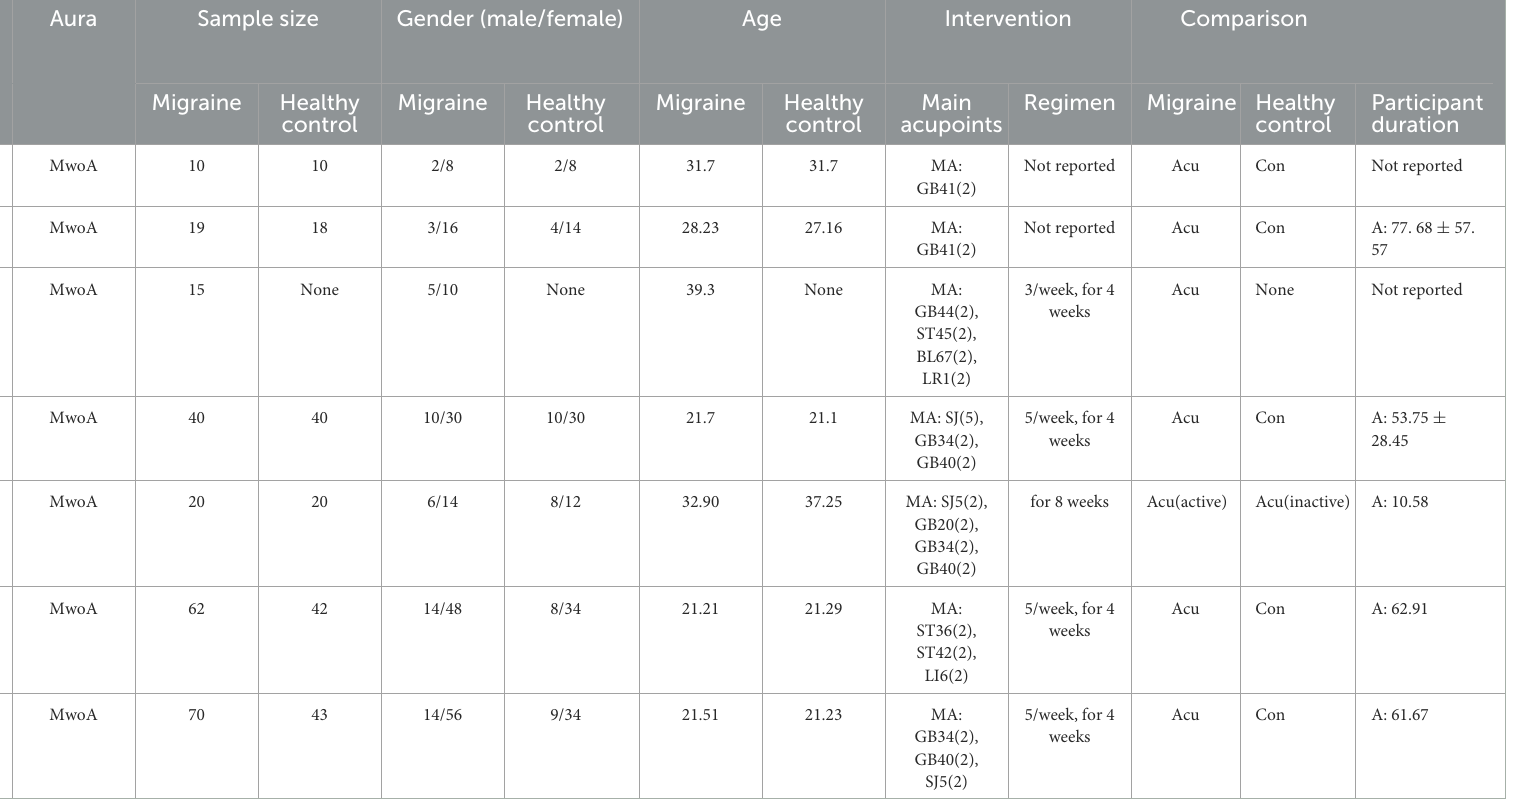
TABLE 1 Demographic and clinical characteristics of included